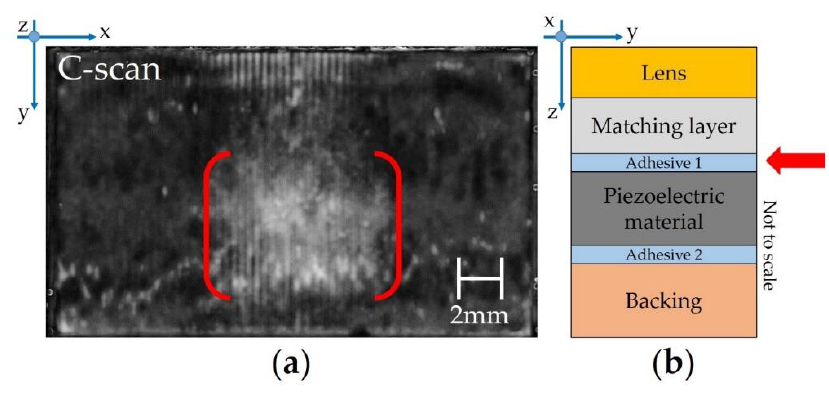
Figure 5. SAM image of adhesive 1 layer: ( a ) C-scan; ( b ) location of the detected layer in the acoustic stack.